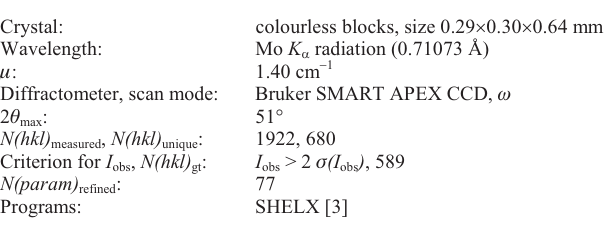
Table 1. Data collection and handling.